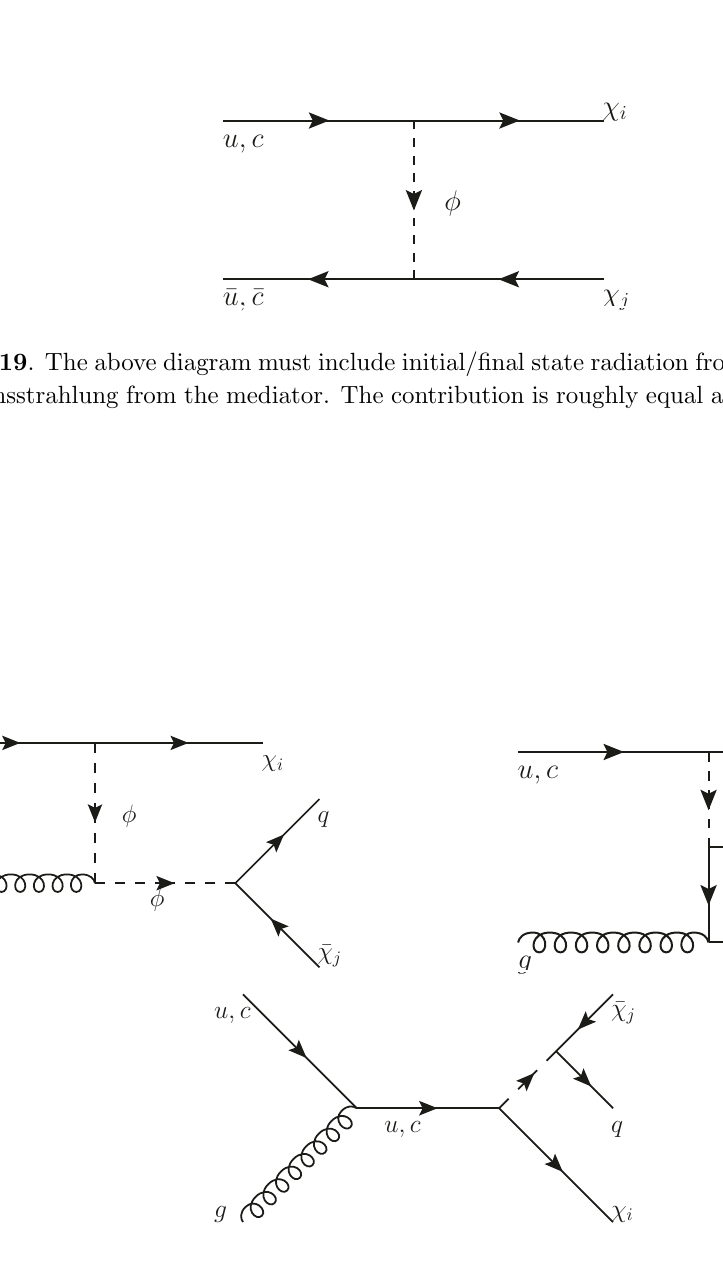
Figure 20 . The s-channel (cid:30) resonance is responsible for (top left) and (bottom) dominating over (top right), and the additional enhancement due to the gluon pdf over (cid:12)gure 19 makes these the overall dominant monojet contribution. For very heavy mediators (top left) is suppressed due to the two